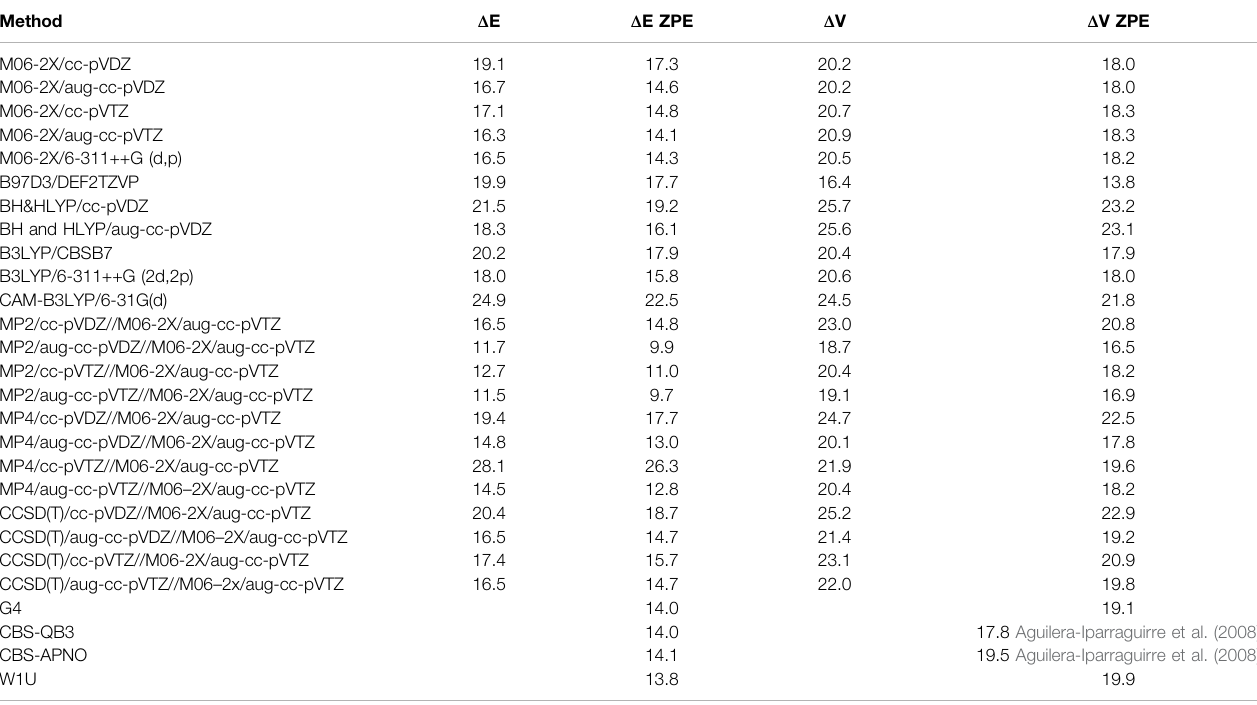
TABLE 2 | Calculated classical ( V C ) and zero point corrected ( V a g ) barriers for the C 2 H 6 + · OOH → · C 2 H 5 + H 2 O 2 (numbers are in kcal/mol). Method Δ E Δ E ZPE Δ V Δ V